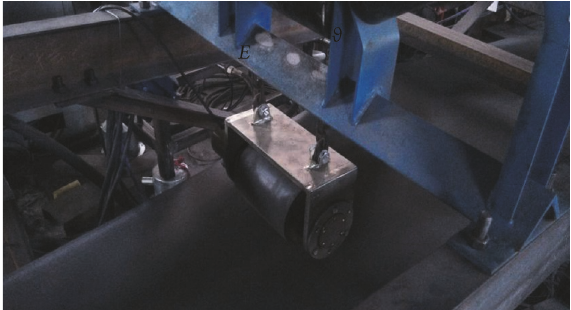
Figure 15: The site map of acceleration test.